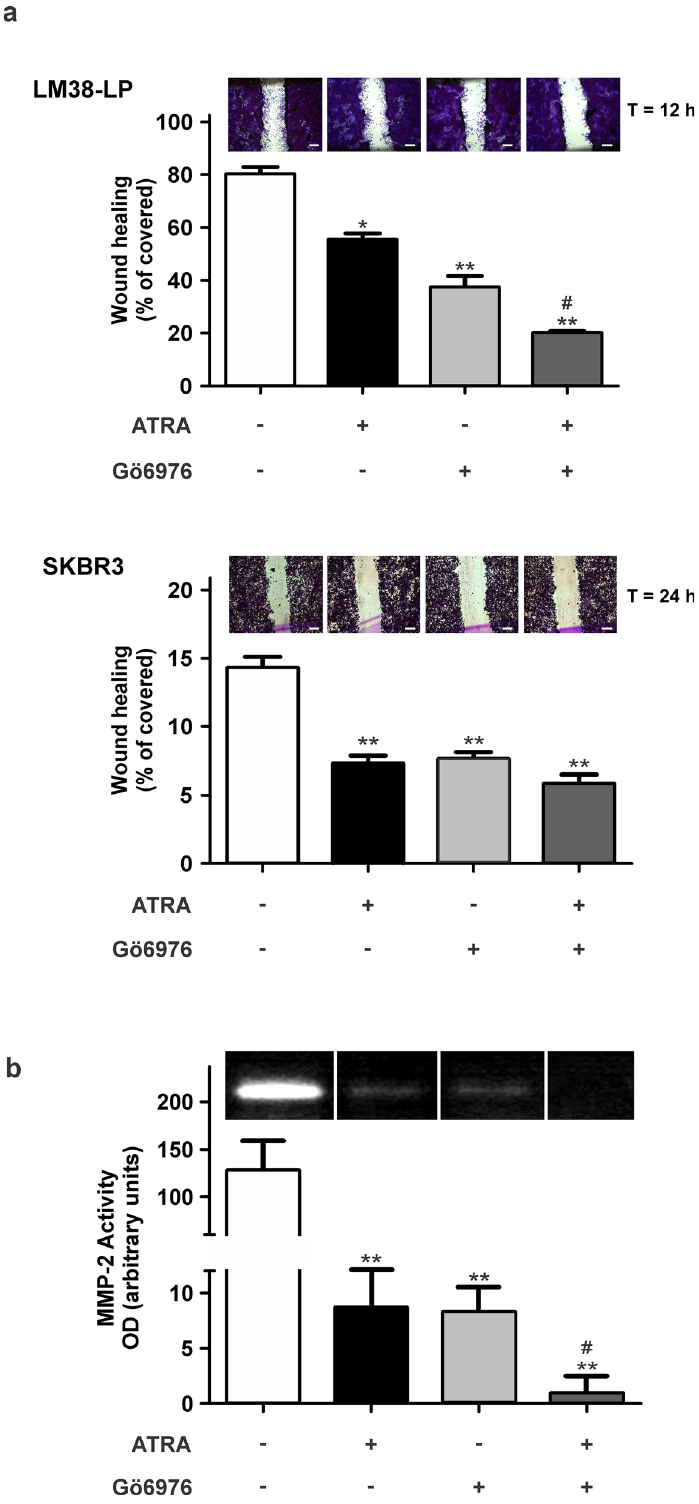
Figure 4. Modulation of migratory potential and soluble MMP-2 activity. ( a ) Monolayers pre-treated for 48 h with ATRA (0.5 µM) and/or Gö6976 (0.5 µM) or vehicle alone as control were “wounded” at time 0 and cells were allowed to migrate into the cell-free area for 12 h (LM38-LP cells) or 24 h (SKBR3 cells). Cell migration was quantified by calculating the percentage of area occupied by cells that migrated into the original cell-free wounded area. Data are expressed as mean ± S.D. of triplicate determinations, * p < 0.05 versus control, ** p < 0.01 versus control, # p < 0.05 versus Gö6976 and ATRA (ANOVA test). Three independent experiments were performed. Inset: Representative photographs of wounded monolayers at final time are shown (Scale bar = 50 μm) : Quantification of MMP-2 secreted activity of pre-treated LM38-LP monolayers. MMP-2 lytic bands were digitalized with a Photo/Analyst Express System and signal intensity was quantified with Gel-Pro Analyzer software. Data represent mean ± S.D. of triplicate determinations, ** p < 0.01 versus control, # p < 0.05 versus Gö6976 and ATRA (ANOVA test). At least 3 independent experiments were performed with similar results. Inset: Cropped bands corresponding to a representative zymogram are